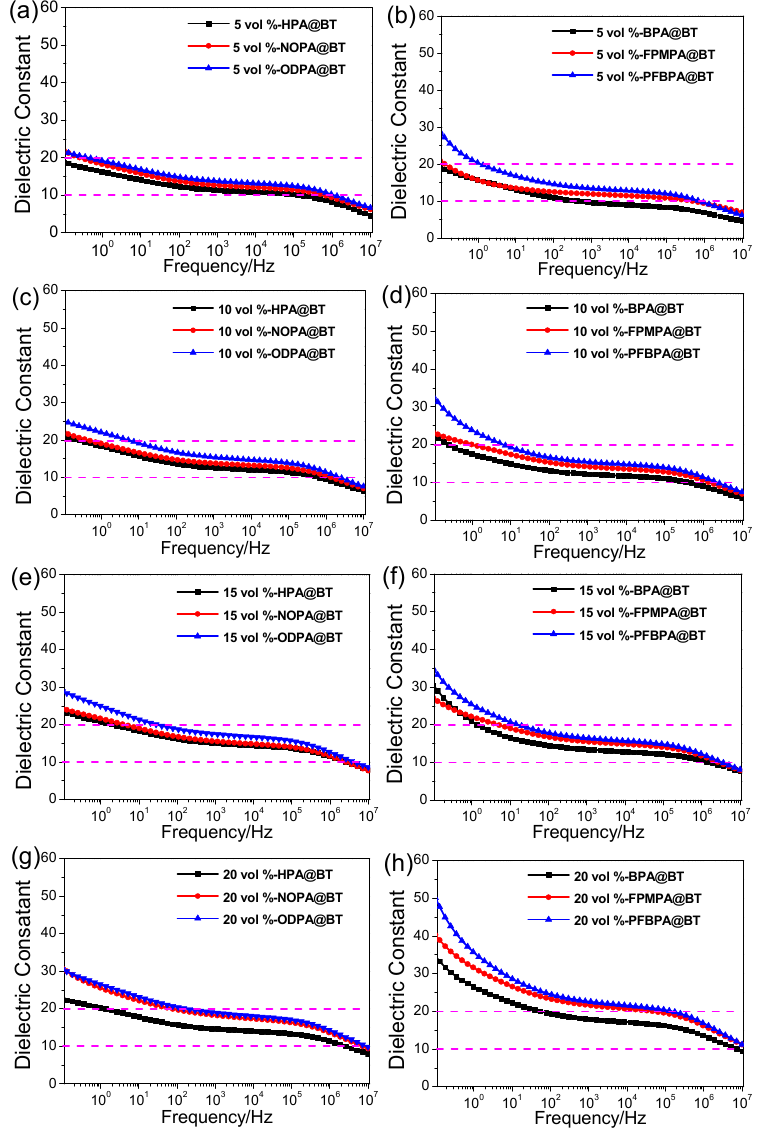
Figure 2. Frequency dependence of the dielectric constant of the P(VDF-HFP) nanocomposite films with different volume fractions of modified BT ( a – h